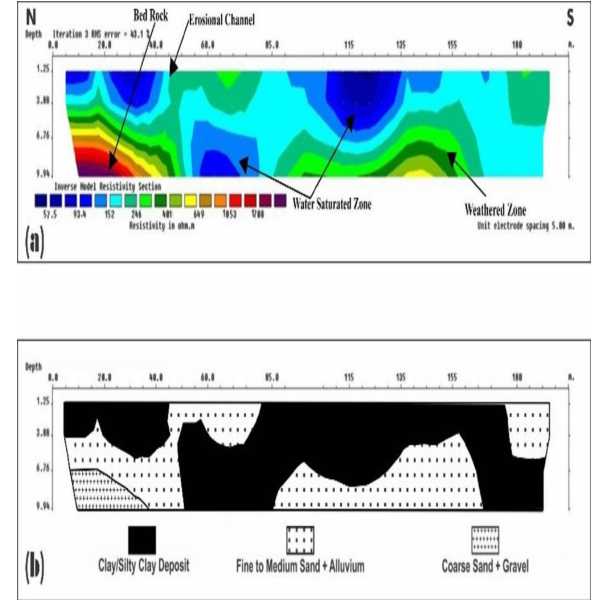
Fig. 4. (a) Profile 1 electrical resistivity tomography; (b) Geologic cross-section interpreted from the resistivity model within a sequence of horizontal sedimentary sequence (see Fig. 3).